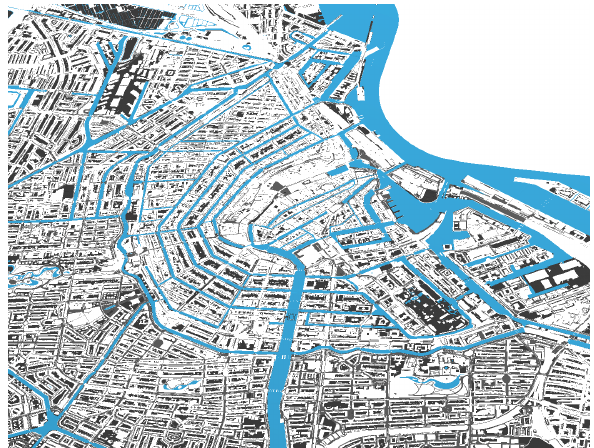
Figure 5. Amsterdam model exported by NOVAfactory,